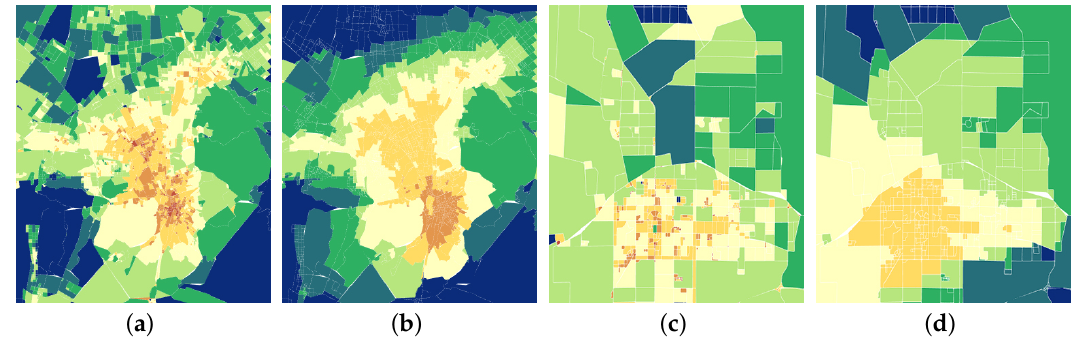
Figure 12. Comparison of estimated population density with baseline density for Urumqi and Shihezi. We use MATLAB [27] R2015b to generate the map-style image. ( a ) Estimated Population distribution in Urumqi. ( b ) Baseline population distribution in Urumqi. ( c ) Estimated Population distribution in Shihezi. ( d ) Baseline population distribution in